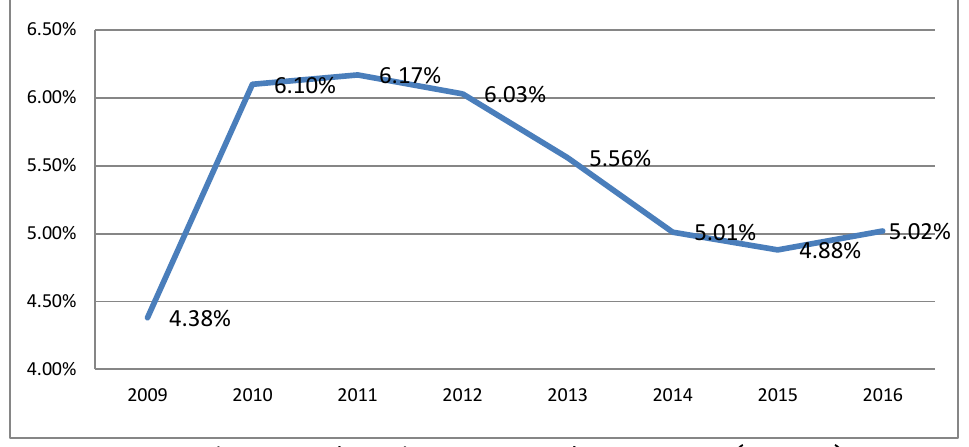
Figure 1 Indonesia GDP Growth 2009-2016 (Percent) Source: Secondary data from the Central Body of Statistics which was processed by the